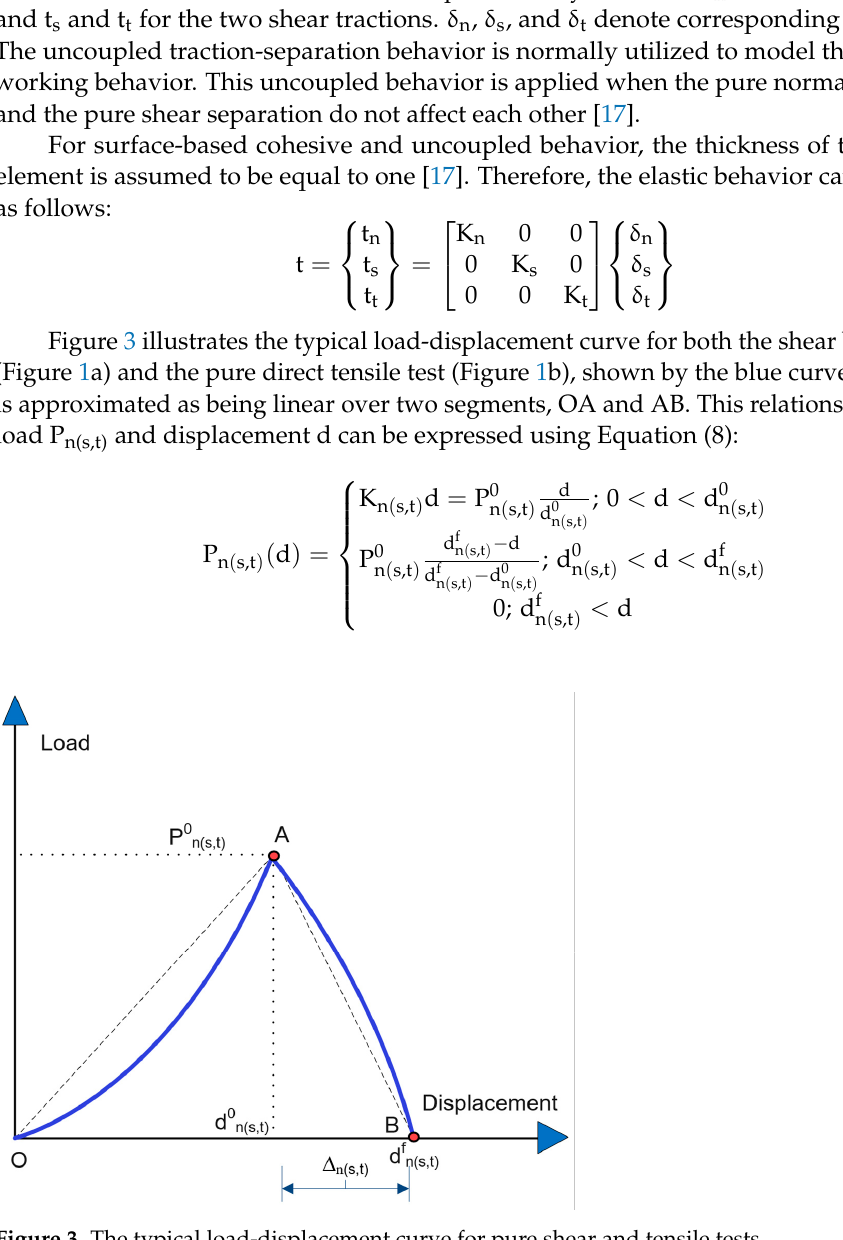
Figure 3. The typical load-displacement curve for pure shear and tensile tests. The ultimate loads of each mode are P n ◦ , P s ◦ , and P t ◦ , with corresponding displace- ments of d n ◦ , d s ◦ , and d t ◦ , respectively. The highest displacement at the end of each damage evolution is represented by d n f , d s f , and d t f . The differences between the highest and corresponding displacements are denoted as ∆ n , ∆ s , and ∆ t